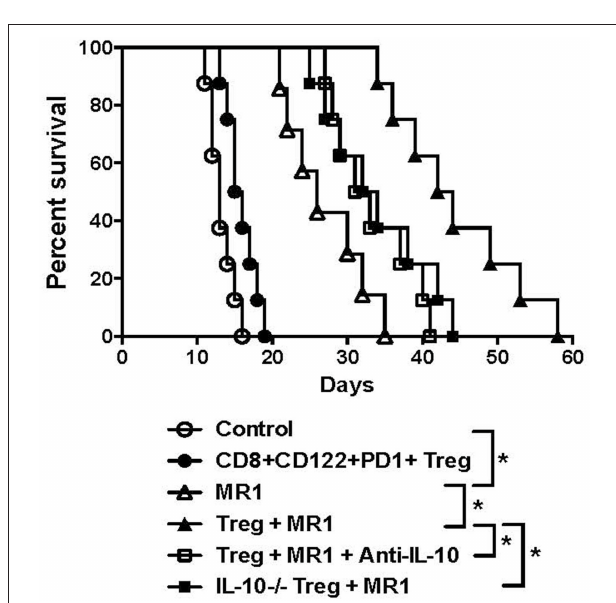
FIGURE 6 | Synergy in suppression of allograft rejection between CD8 + CD122 + PD-1 + Tregs and costimulatory blockade of CD154 is largely dependent on IL-10. C57BL/6 mice that received IL-10-replete or IL-10-deficient CD8 + CD122 + PD-1 + Tregs were transplanted with BALB/c skin. They were also treated with MR1 (anti-CD154) while some received anti-IL-10 Ab to neutralize IL-10. Skin allograft rejection was observed ( n = 7–8, * P <